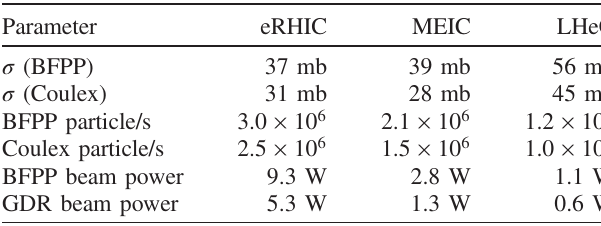
TABLE II. Cross sections and reaction rates for BFPP and Coulex and the beam power for BFPP and GDR